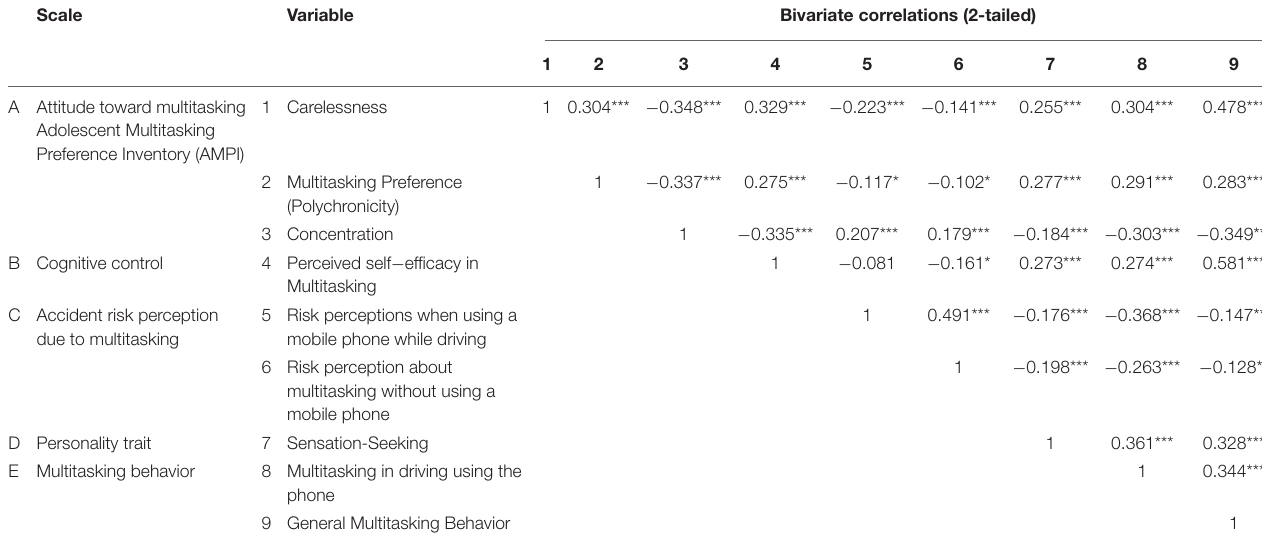
TABLE 1 | Pearson bivariate correlations of the investigated variables. Scale Variable